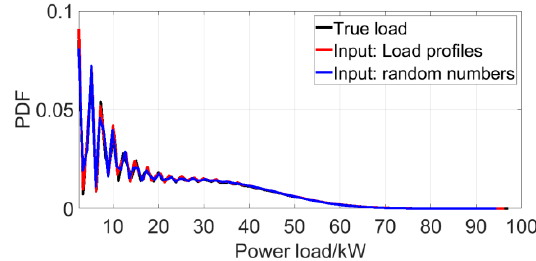
Figure 11. Probability density function of BEV_NODR.